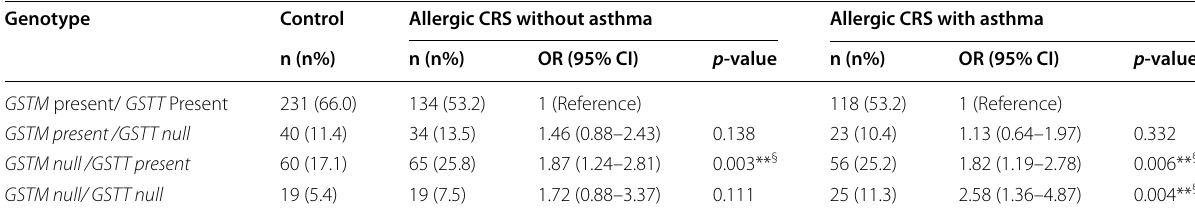
OR Odds ratio, CI -Confidence interval OR obtained after Multinomial logistic regression